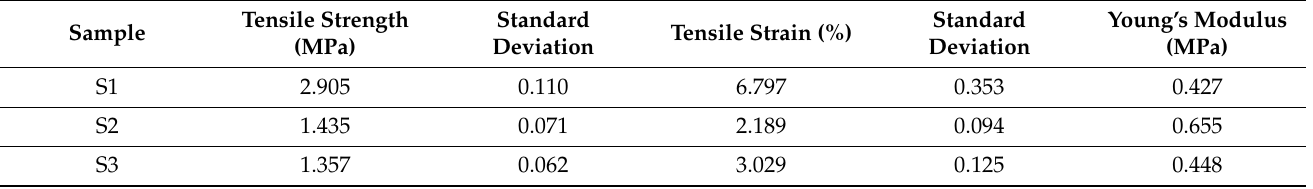
Table 4. Comparison of tensile strength, tensile strain and Young’s modulus of the prepared samples.